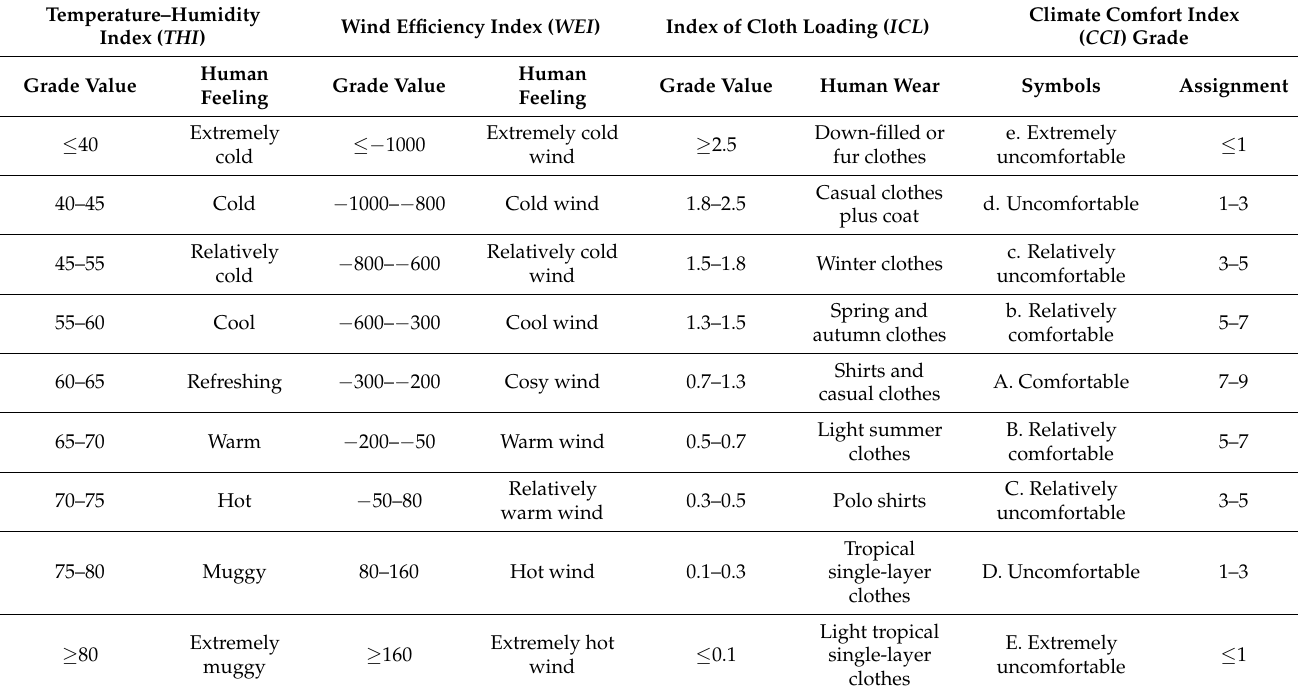
Table 1. The grading standard of THI , WEI , ICL , and CCI .